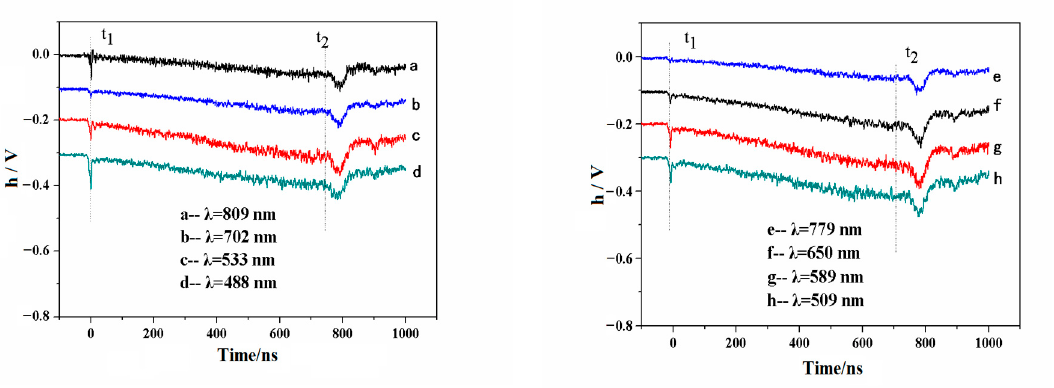
Figure 3. Radiation intensity curves measured from the pyrometer (along the vertical axis, h is the magnitude of the signal from the oscilloscope, indicated in volts).